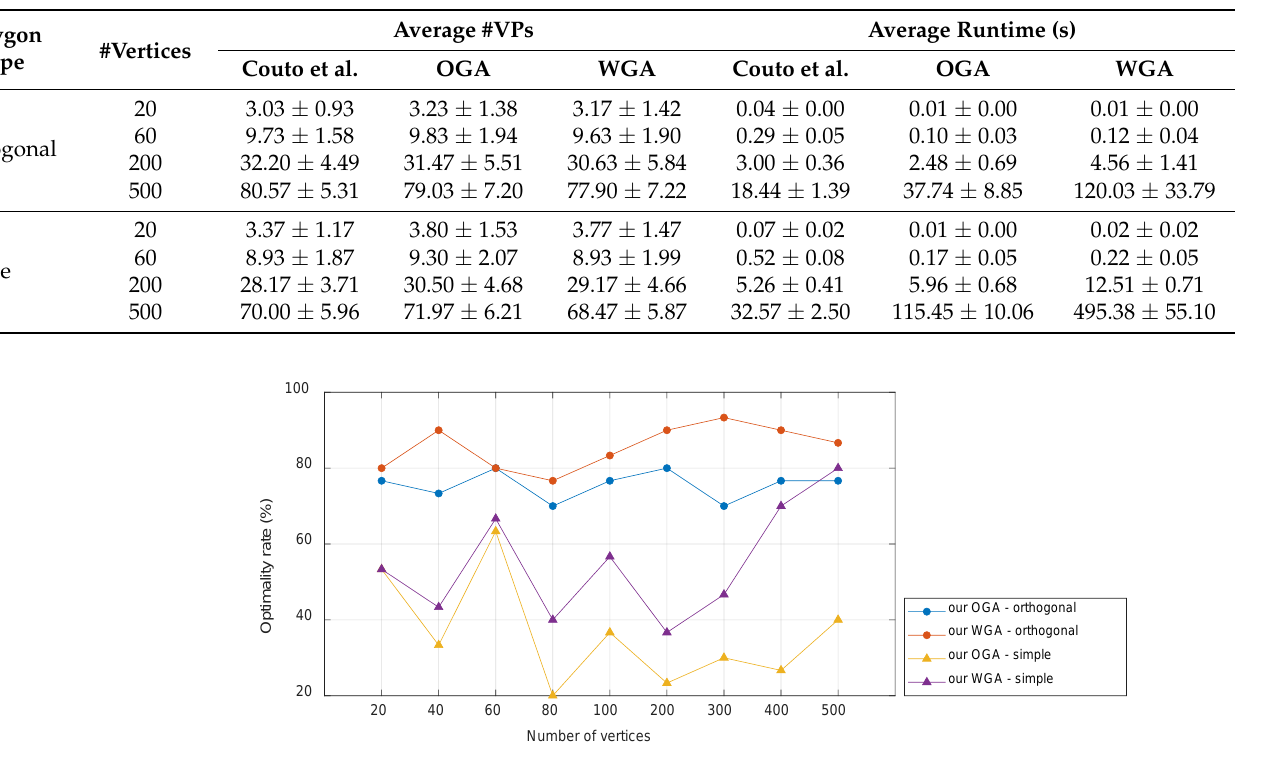
Figure 12. Optimality rate of the proposed methods to the benchmark paper method.